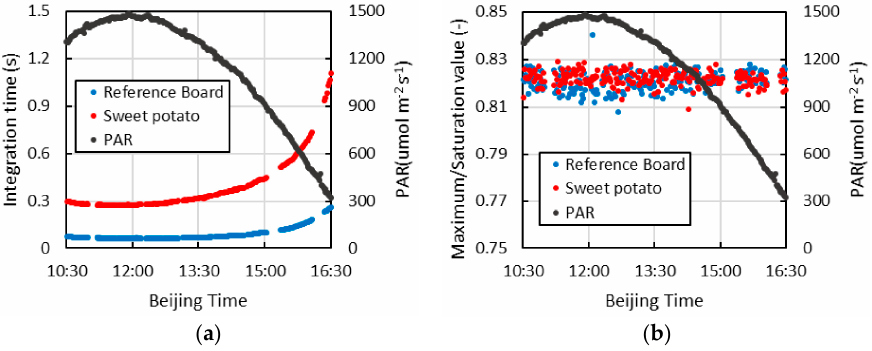
Figure 9. The integration time of using this continuous observation system to measure the spectrum of the reference plate and the canopy of sweet potatoes and the rate of maximum counts after optimizing the integration time to the saturated counts; ( a ) the integration time of measurement; ( b ) the rate of maximum counts after optimizing the integration time to the saturated counts.